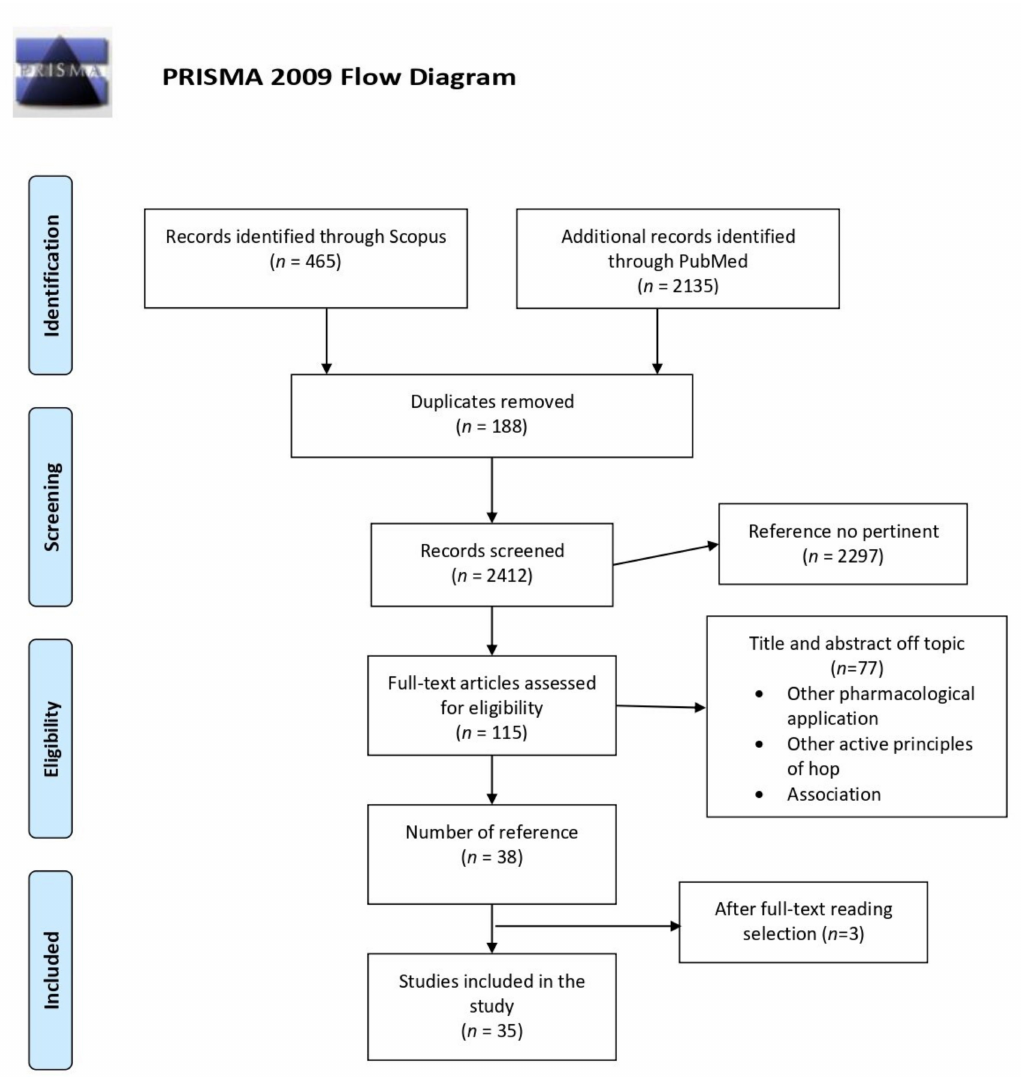
Figure 4. Diagram of systematic review literature search results based on the Preferred Reporting Items for Systematic Reviews and Meta-Analyses (PRISMA)